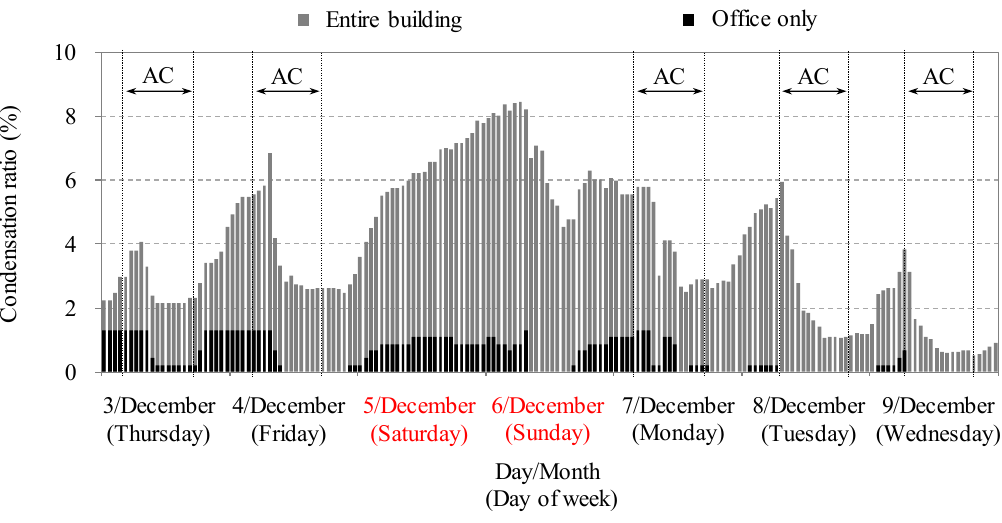
Figure 7. Condensation ratio in a week (December 3–December 9). AC = air ‐ conditioning on.